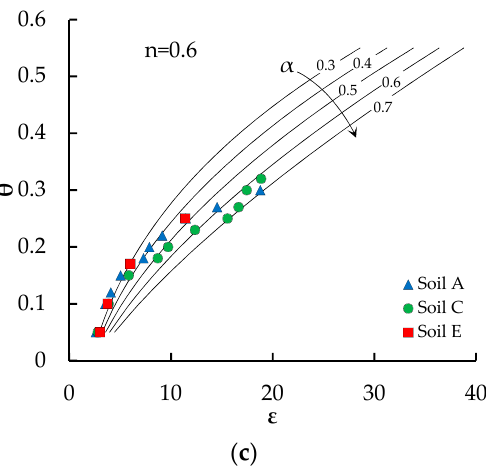
Figure 6. Experimental data at different porosities compared with the three-phase dielectric mixing model of Roth et al. [34] with various values of the exponent α . ( a ) n = 0.5; ( b ) n = 0.55; ( c ) n = 0.6.